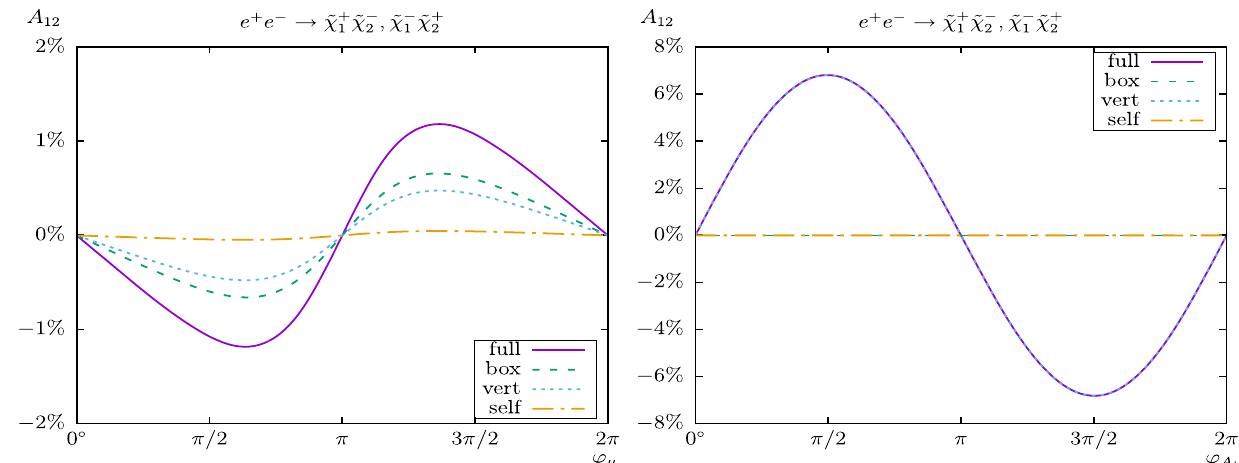
) . CP -odd ied and the different contributions from the box, vertex, and self-energy c (cid:4) corrections including absorptive parts via renormalization constants )var- t